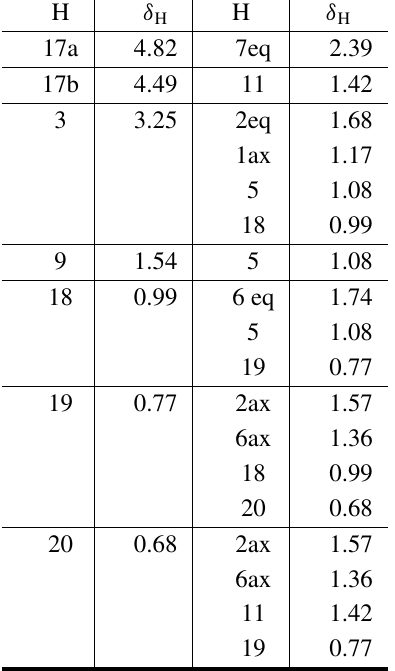
1 H- 1 H-NOESY (dipolar couplings) spectral data for 17 (300 MHz,CDCl 3 , δ